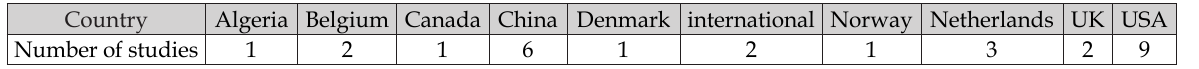
Table 1. Number of studies selected per country.